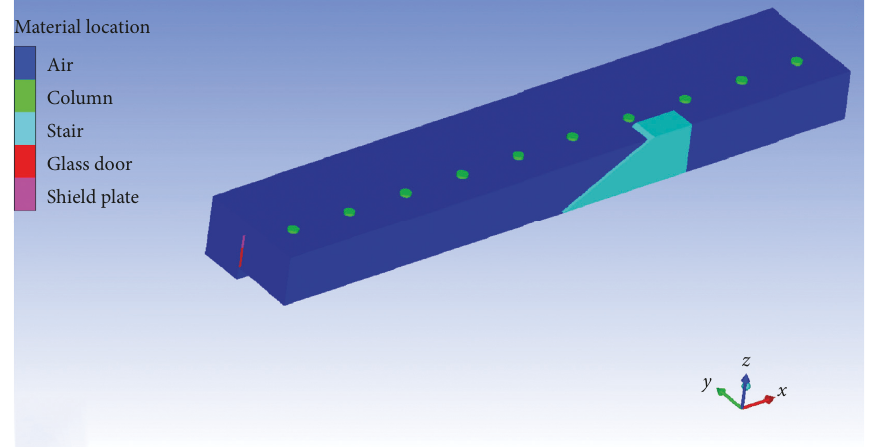
Figure 8: Numerical model of the platform with full-height and fully closed shield doors.